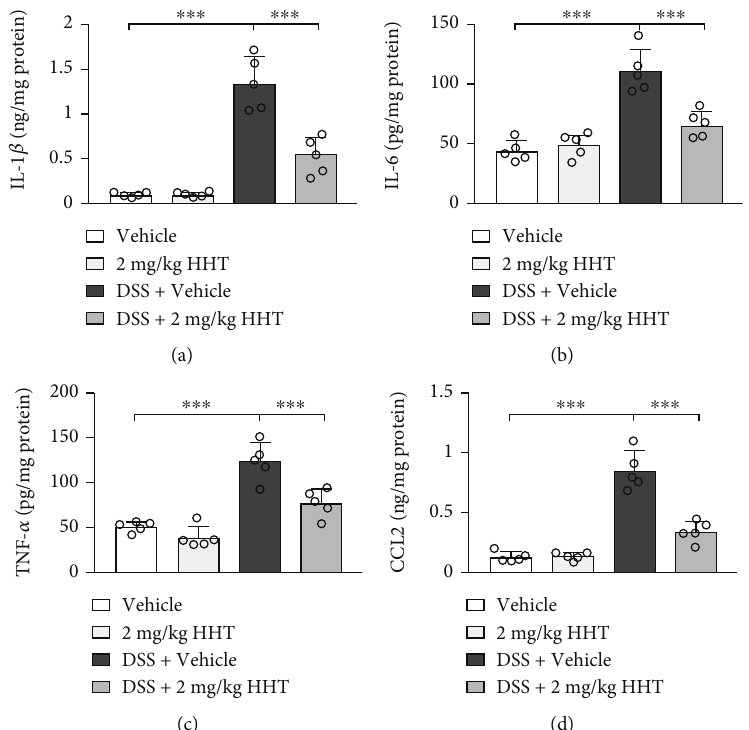
Figure 2: HHT inhibits DSS-induced colon in fl ammation. Mice were treated with 3% DSS along with vehicle or 2mg/kg HHT for seven days, and the colon tissues were homogenized for ELISA of IL-1 β (a), IL-6 (b), TNF- α (c), and CCL2 (d). Five mice per group. Error bar represents mean ± SD . ∗∗∗ p < 0 : 001